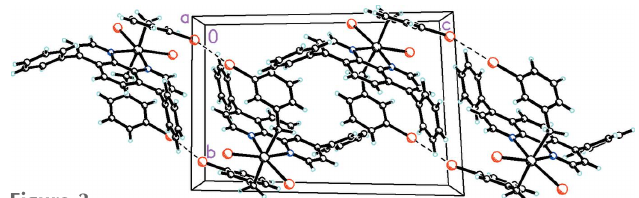
Figure 2 Diagram of (I) (major component only), showing the formation of R 2 rings due to the formation of intermolecular Br (cid:2)(cid:2)(cid:2) Br interactions (shown as dashed